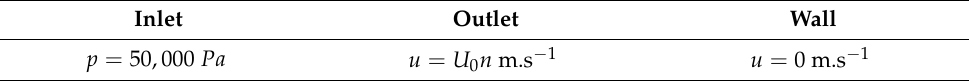
Table 2. Boundary